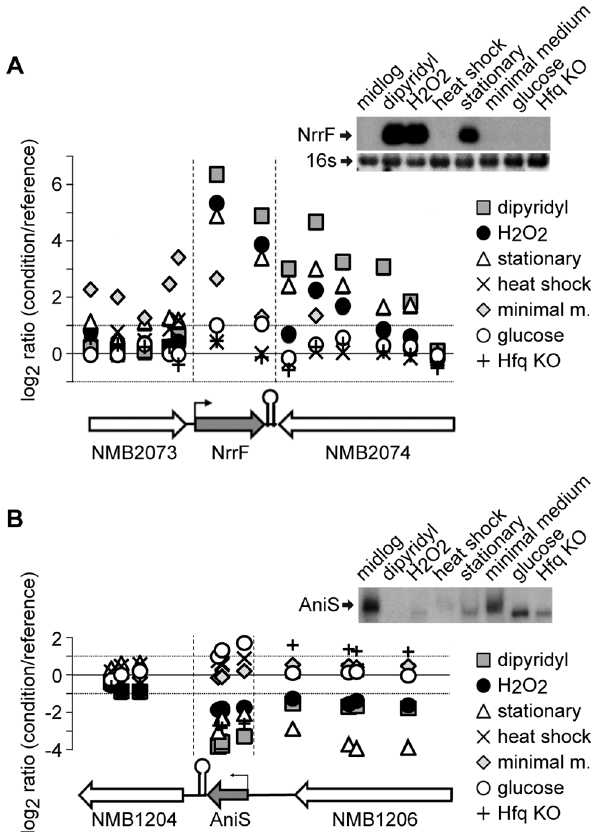
Fig 1. Validation of the high density data through NrrF and AniS expression profile. Expression profile of the NrrF (A) and AniS (B) sRNAs. Graphical representations of tilling array results during growth in the indicated conditions. The y axis shows the M value (log2ratio of expression of the experimental condition versus the reference), while on the x axis the genomic position of the probes is depicted in relationship to the schematic representation of the locus under the graph. ORFs and sRNAs are represented as white or grey horizontal arrows, respectively and the transcriptional starting sites and the terminators of sRNAs are indicated. Vertical black dashed lines indicate the position of sRNAs. Dotted black horizontal lines limit the background signal in which the probes are not considered to be regulated. Each dot in the graph corresponds to the average of the M values for one probe from three independent replicates in the indicated condition. On the upper right, experimental validation of the tilling array results by Northern blot (NrrF) or primer extension (AniS). 16s ribosomal RNAs provided a loading control for the Northern Blot experiment. The only notable inconsistency among microarray data and validation is the down-regulation of AniS in primer extension experiments during heat shock treatment. This discrepancy could be due to the fact that microarray probes and the primer used for validation do not recognize the same portion of AniS.